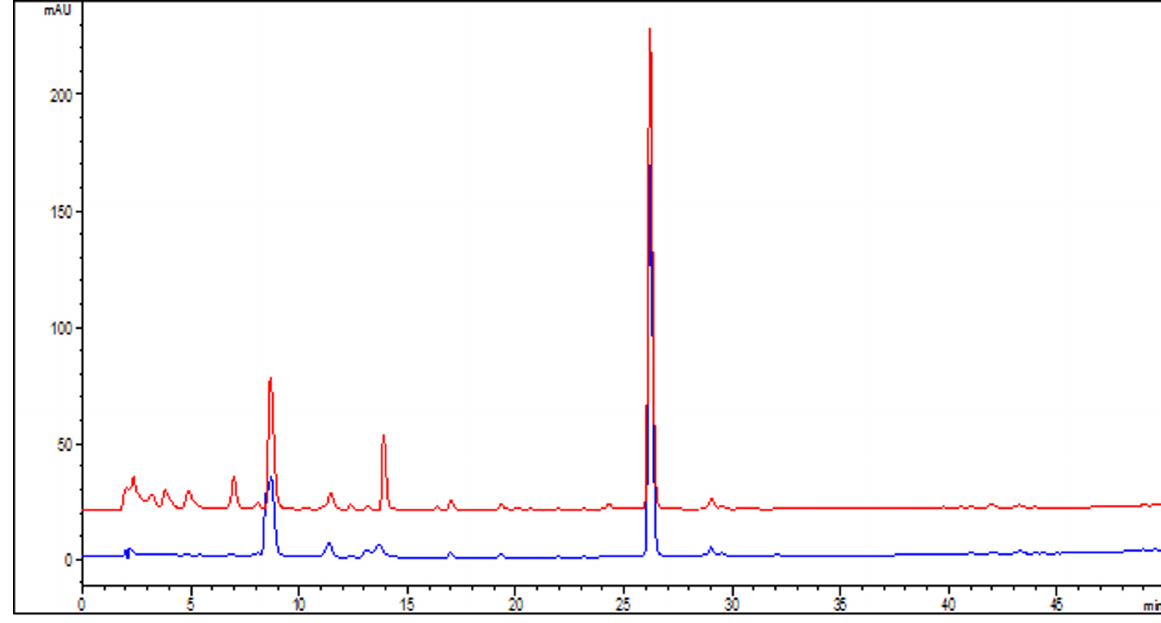
Figure 4. Comparative HPLC chromatograms of M. stenopetala leaves extracted by cold methanol and boiling in water. The top panel shows the leaves powder (1 g) boiled for 30 min and lower panel cold methanol for 20 min. Notice that no extra peaks were detected in the boiling preparation before or after the rutin peak (just after 26